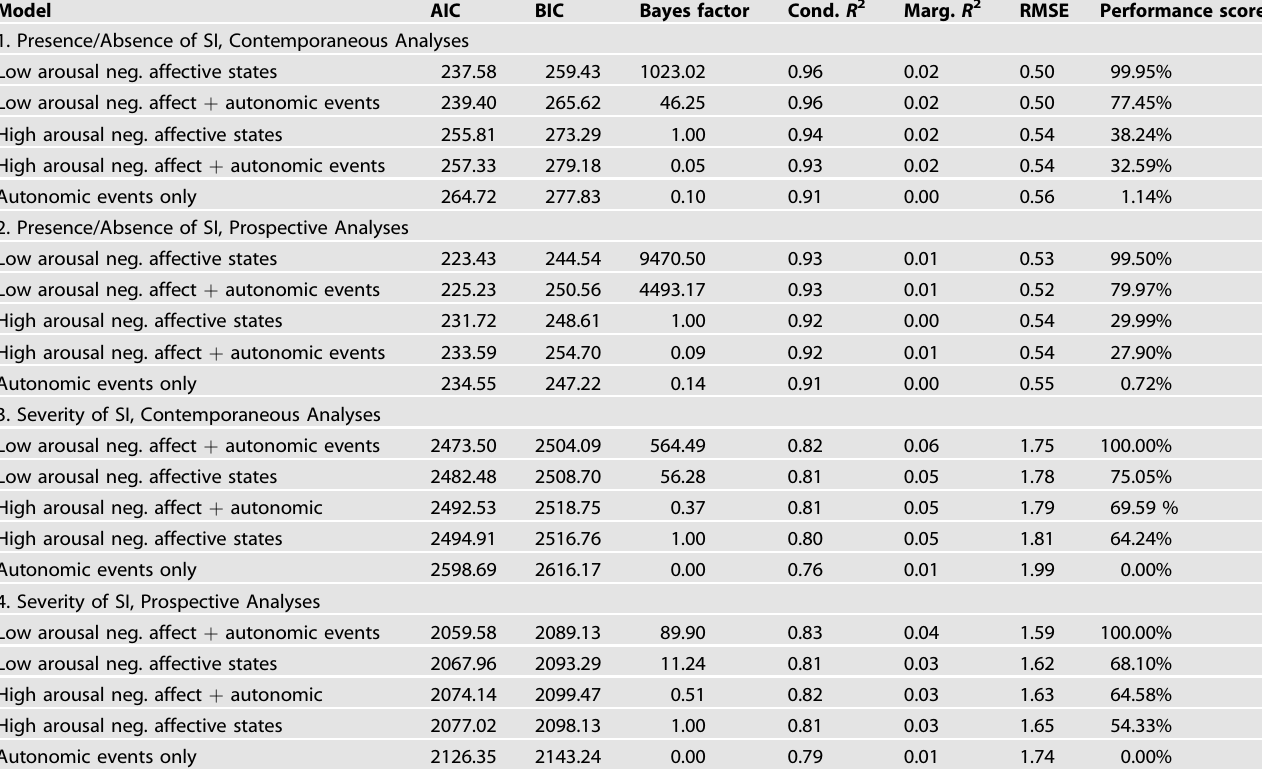
Table 1. Model information and model comparison statistics for daily-level data, ordered by